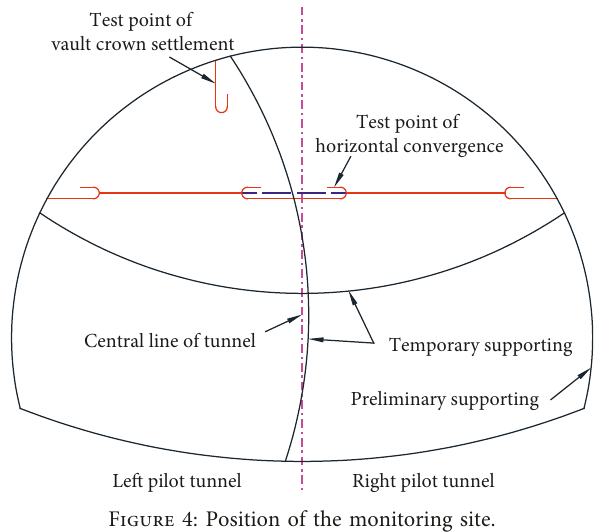
Figure 4: Position of the monitoring site.